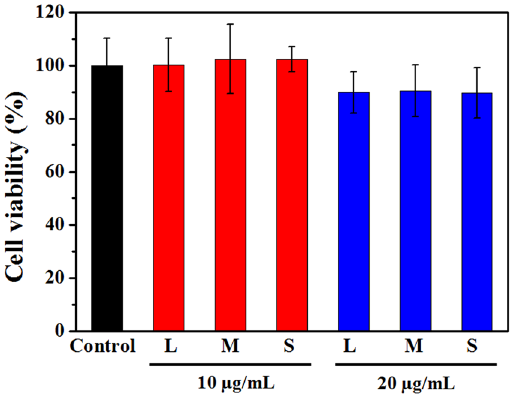
Figure 2. The viability (Treatment/control) of cells treated with different concentrations of L-SWCNTs (L), M-SWCNTs (M), and S-SWCNTs (S) for 24 h, as determined by WST-1